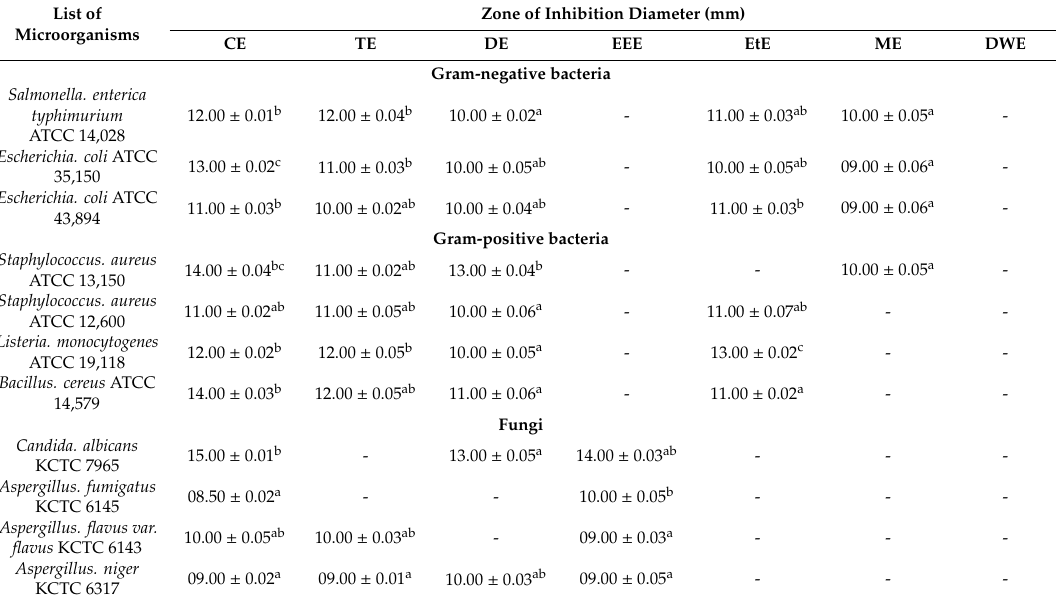
Table 1. Antimicrobial activity of di ff erent extracts of red cabbage (RC). List of